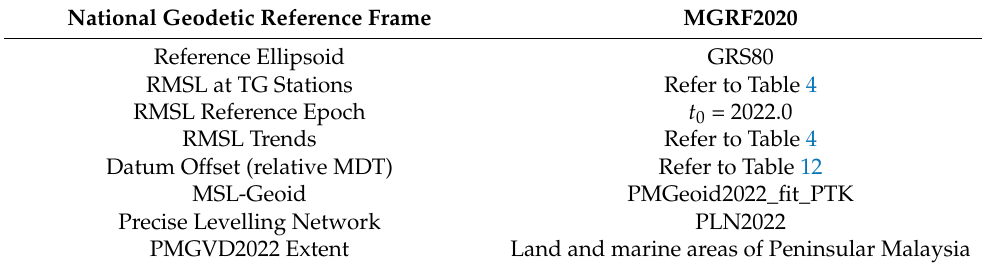
Table 13. PMGVD2022 defining parameters and extent.